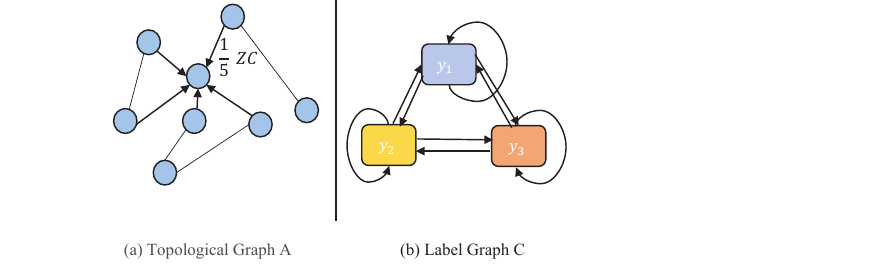
Figure 2. The aggregation operator of our method, aggregates the label information transited k steps via transition matrix from its k-hop neighbor and weighted with the probability of random walk.